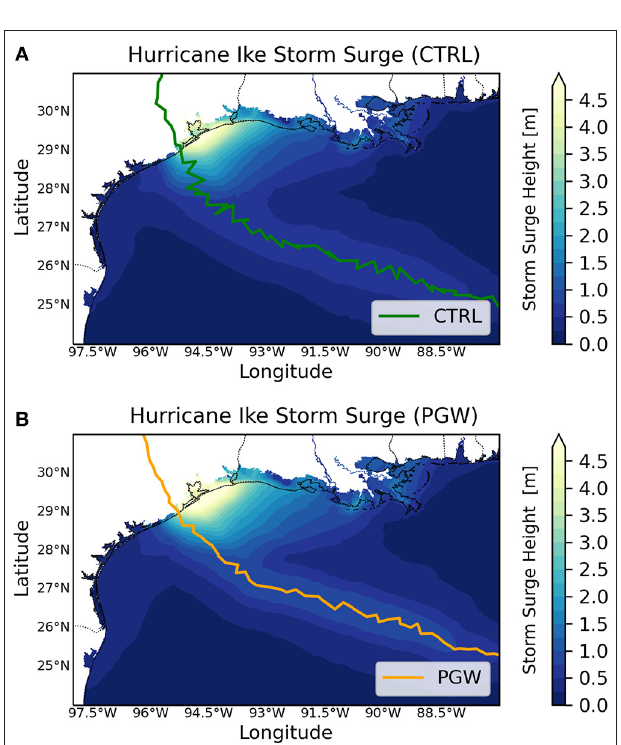
TABLE 1 | Total inundation volumes computed for each hurricane and corresponding changes over the 21st century.